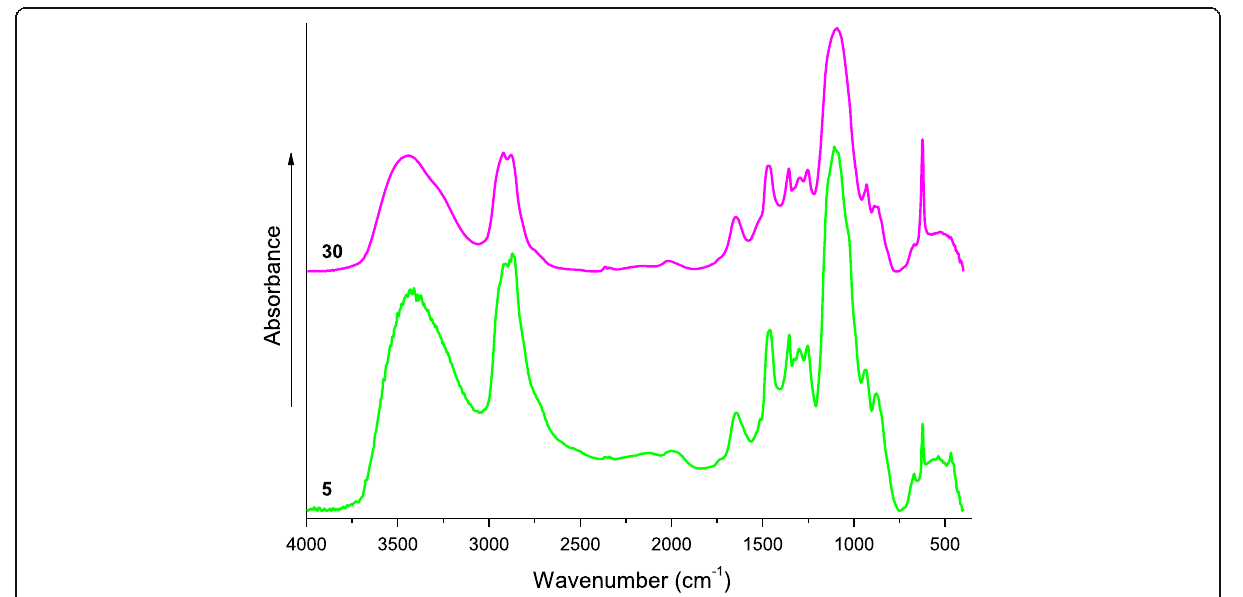
Fig. 5 The IR spectra (in tablets of KBr). The IR spectra of the composites with different LiClO 4 content (marked by numbers near curves)